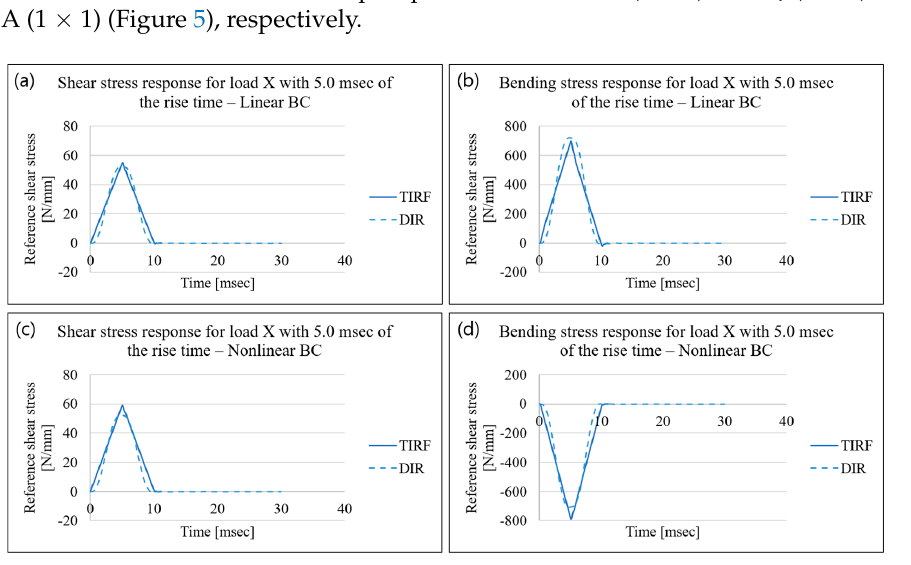
Figure 12. Reference shear and bending responses for Load X (uniform pressure 3 × 3 load case) using TIRF and DIR for impact pressure of 5.0 ms of rise time: ( a ) Reference shear responses with linear boundary conditions, ( b ) Reference bending responses with linear boundary conditions, ( c ) Reference shear responses with nonlinear boundary conditions, and ( d ) Reference bending responses with nonlinear boundary conditions.